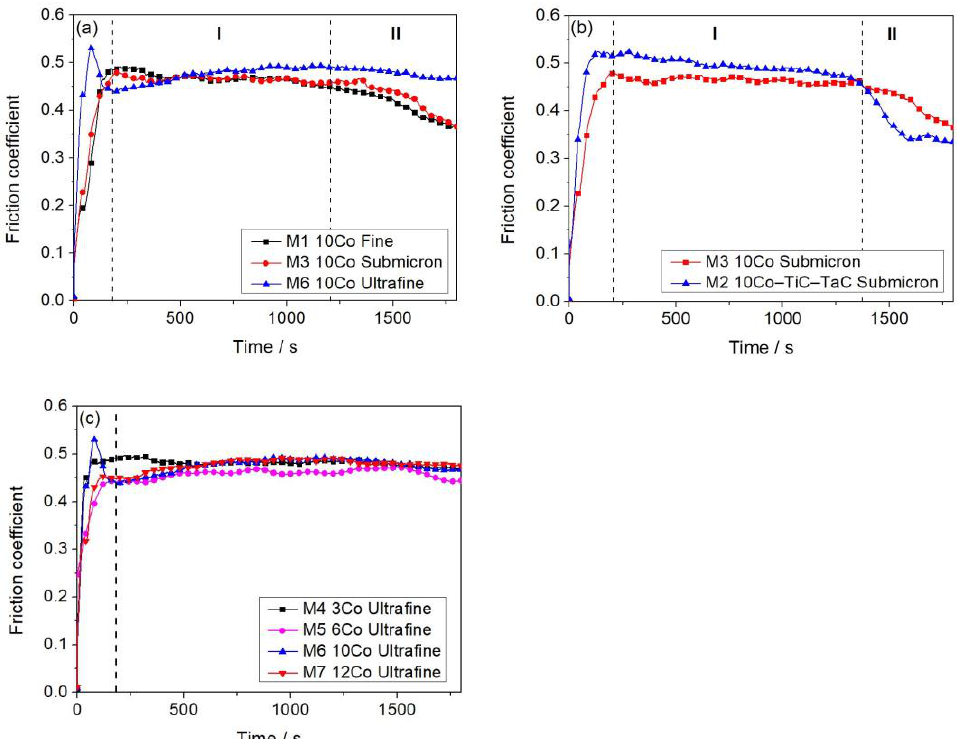
Figure 4. Friction coefficients of coated cemented carbides with different substrates: ( a ) 10Co alloys with different WC grain sizes; ( b ) 10Co alloy containing cubic carbide phase; ( c ) ultrafine alloys with different Co contents.